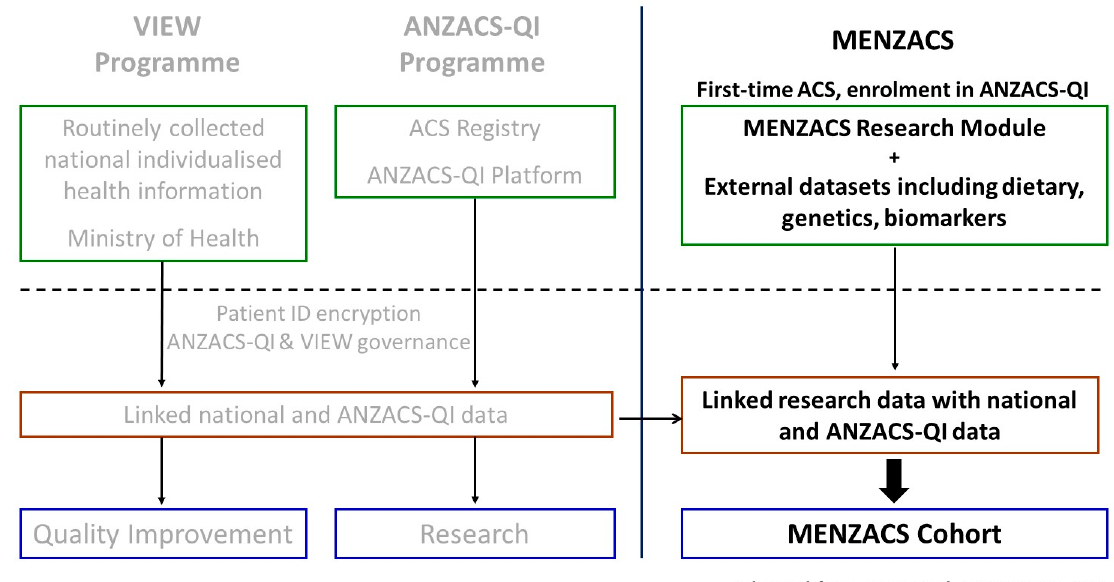
Figure 1. Schema showing the data platforms and linkages that result in the MENZACS cohort.